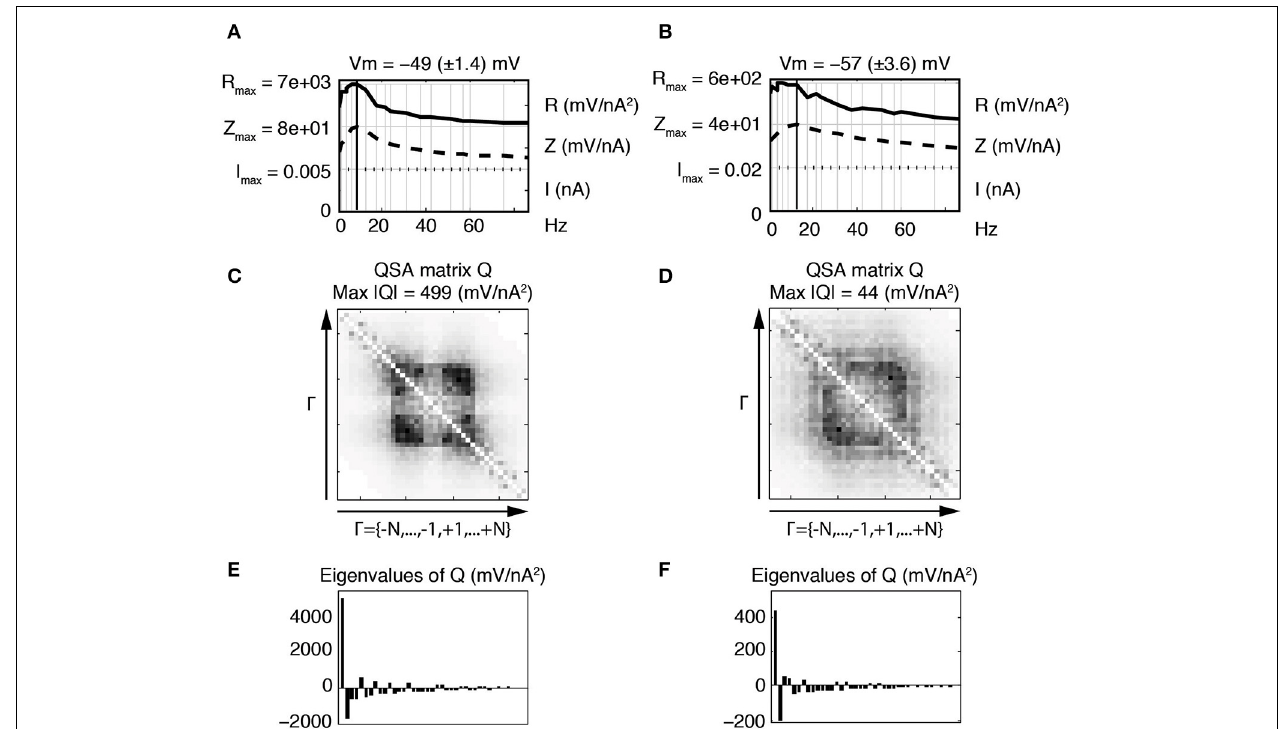
FIGURE 4 | Effect of the membrane potential level on linear and quadratic responses of stellate neuronal model simulations at − 49mV (left column) and − 57mV (right column). (A,B) Juxtaposed plots with respect to the input frequencies, namely the amplitudes of current stimulation I , linear impedance Z , and R function. The resonance frequencies are respectively f 8 = 8 . 7Hz (A) and f 9 = 12 . 1Hz (B) . (C,D) Amplitudes of the coefficients of the QSA matrix Q with the maximum value given by Max | Q | . (E,F) Eigenvalues of the QSA matrix. The model parameter values (in